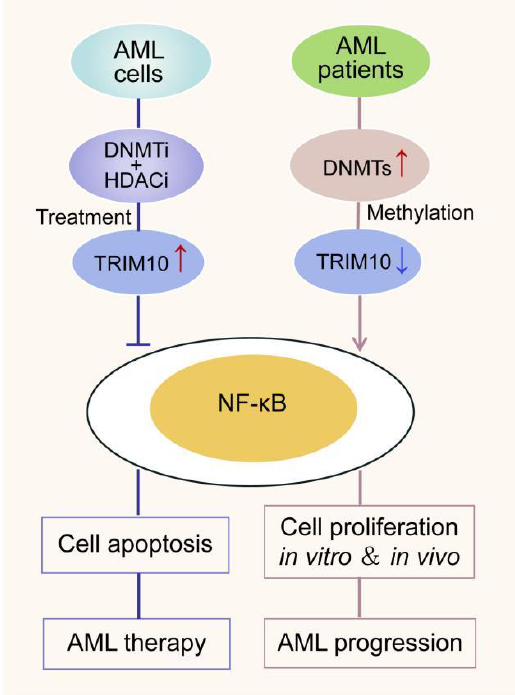
Figure 7. The model of our working